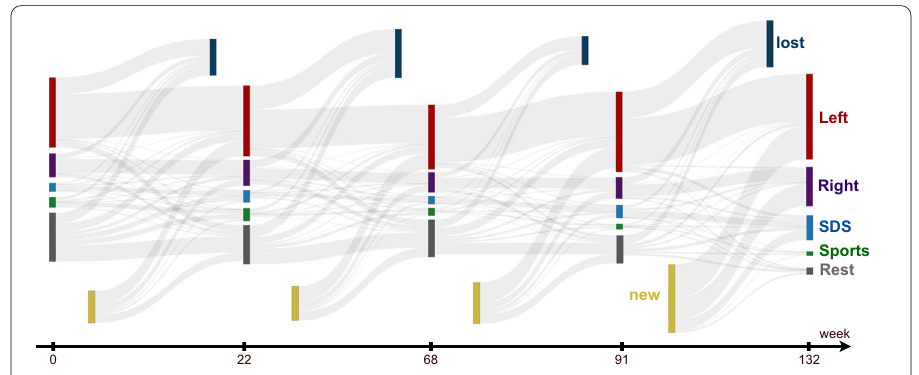
Fig. 2 A Sankey diagram showing community membership transitions at the five selected timepoints t = 0,22,68,91,132 . We focus on four major communities: Left (red), Right (violet), SDS (blue), and Sports (green). The remaining, typically smaller, communities are denoted as Rest. At each timepoint, there are new nodes joining the retweet networks, and lost nodes leaving the